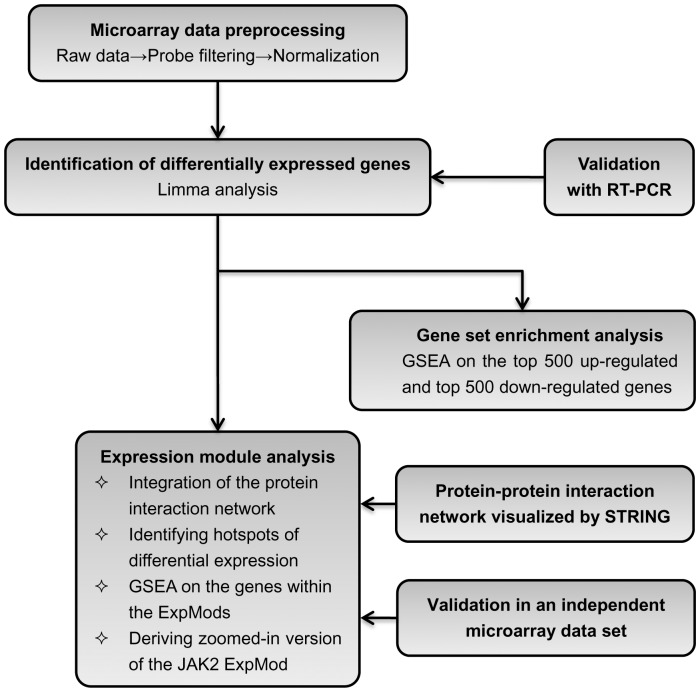
Experimental design.The flowchart schematizes the experimental steps of the statistical analysis of microarray data.